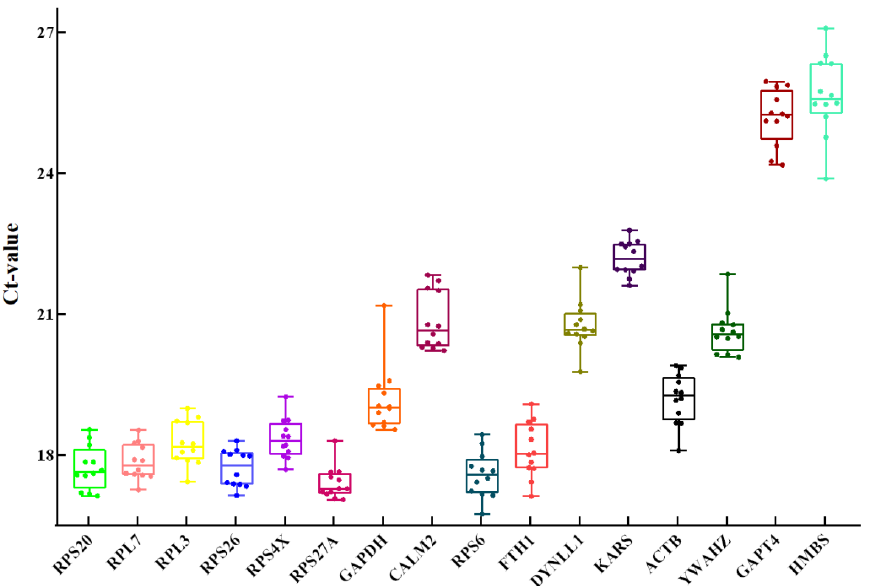
Figure 1. Range and dispersion of Ct values of candidate RGs obtained from all cDNA samples. The ends of each box represent 25% and 75% of the quartile range. The line across the box represents the median value.